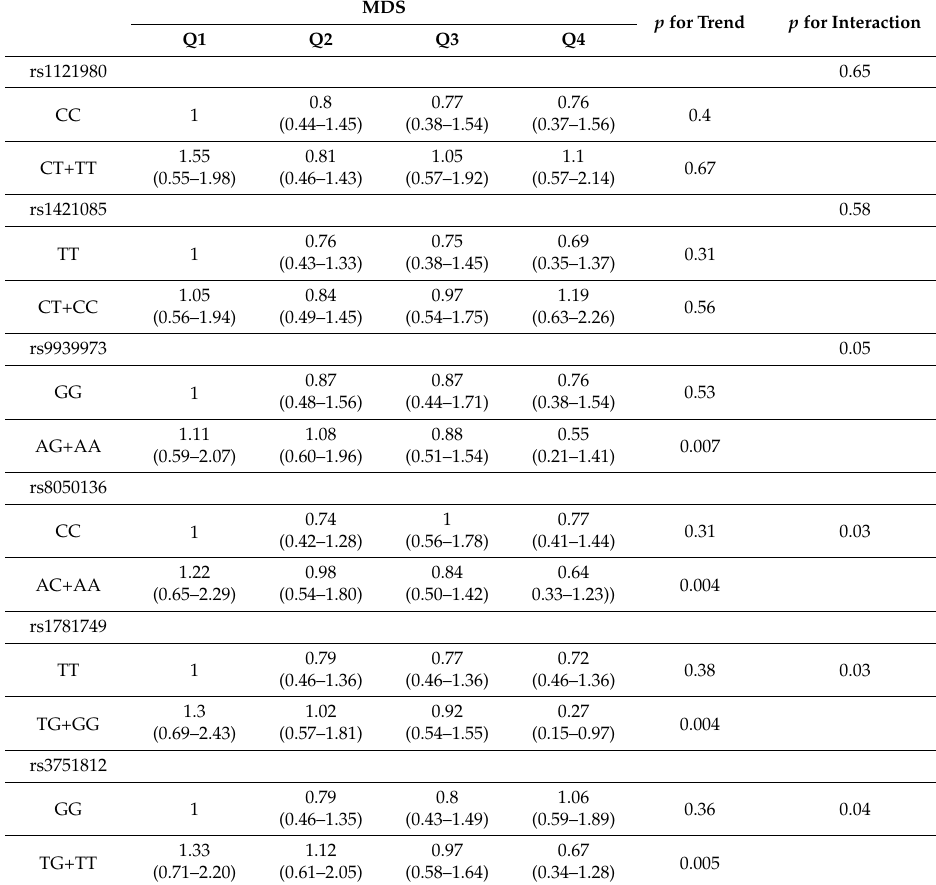
Table 3. Adjusted ORs (95%CI) for obesity according to quartiles of MDS by FTO SNP genotypes a (Tehran Lipid and Glucose